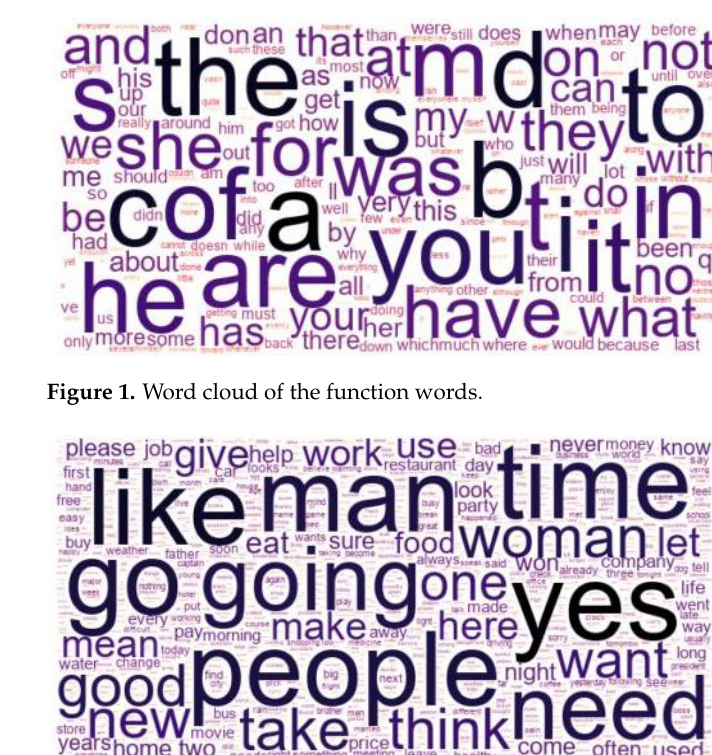
Figure 1. Word cloud of the function words.